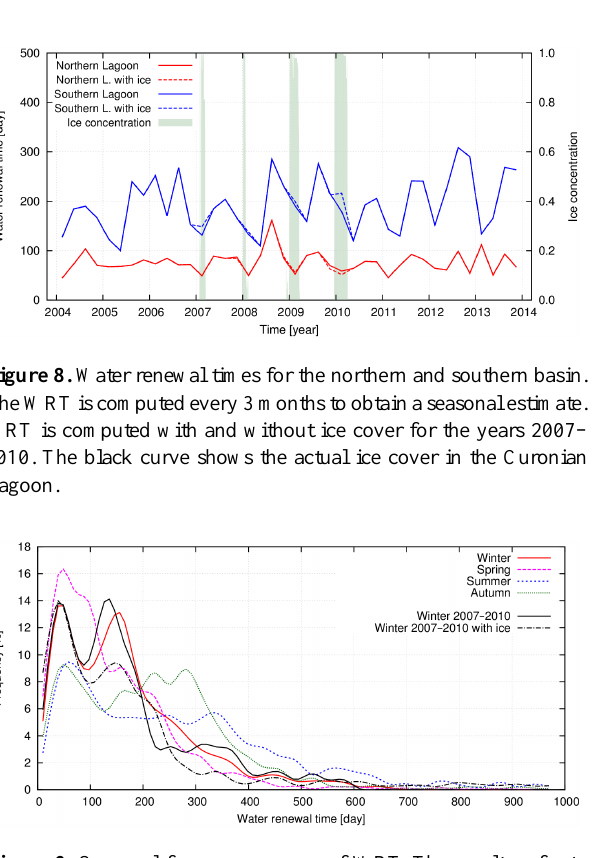
Figure 9. Seasonal frequency curves of WRT. The results refer to the whole 10-year period except the black curves, which indicate the situation with and without ice cover in winter only for years